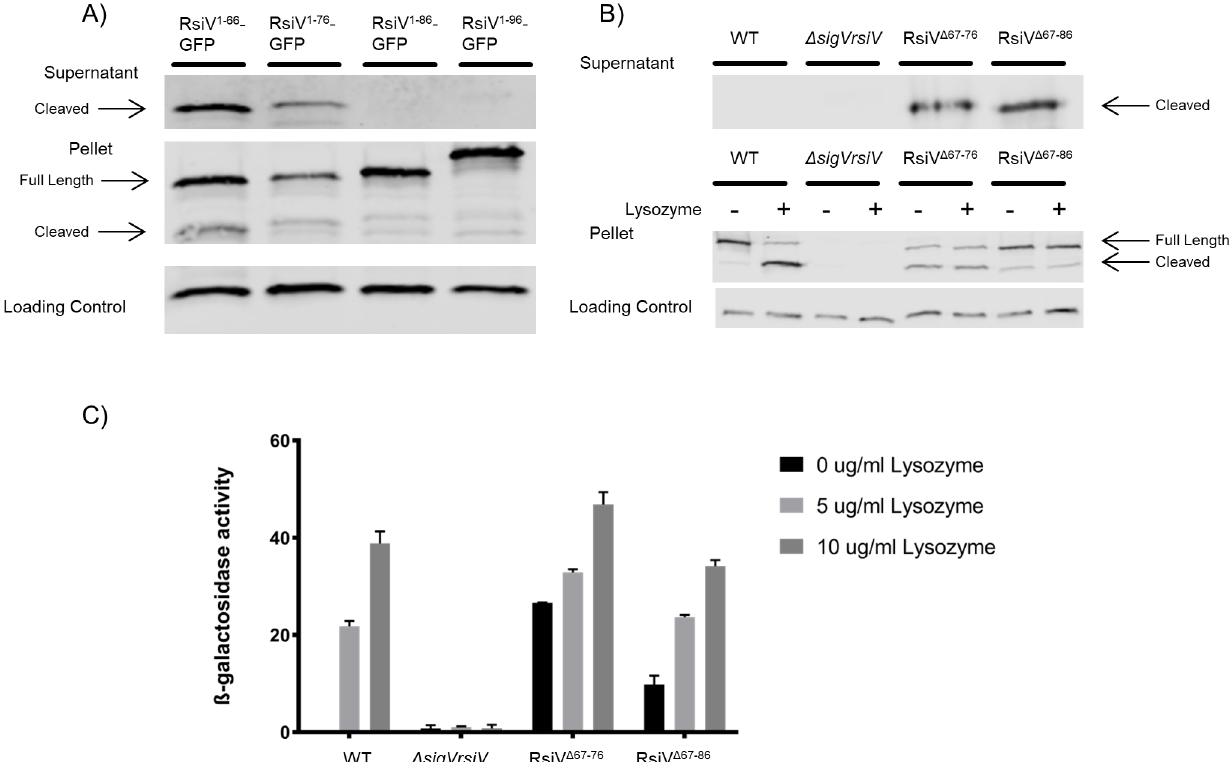
Fig 2. Amino acids after the cleavage site are involved in the protection of RsiV from signal peptidase cleavage. A. Cells producing various lengths of N-terminal RsiV (1–66, 1–76, 1–86 and 1–96) fused to GFP were grown to mid log. Cell pellets and the supernatants were collected and analyzed by western blot with α -RsiV 59-258 antibodies. Streptavidin IR680LT was used detect PycA which served as a loading control [67]. The color blot showing both pellet and loading control on a single gel is S2 Fig. B. Deletions in RsiV after the cleavage site were created (RsiV Δ 67–76 , RsiV Δ 67–86 ) and expressed under an IPTG inducible promoter. The supernatants were collected. The cells were then exposed to -/+ lysozyme (10 μ g/mL). Samples were analyzed by western blot with α -RsiV 59-258 antibodies and streptavidin IR680LT was used to detect PycA as a loading control [67]. The color blot showing both pellet and loading control on a single gel is S3 Fig. C. The deletion constructs (RsiV Δ 67–76 , RsiV Δ 67–86 ) were created in a strain that carries a P sigV -lacZ reporter. σ V activity was determined by measuring β -galactosidase activity. This experiment was done in triplicate and standard deviation is represented by error